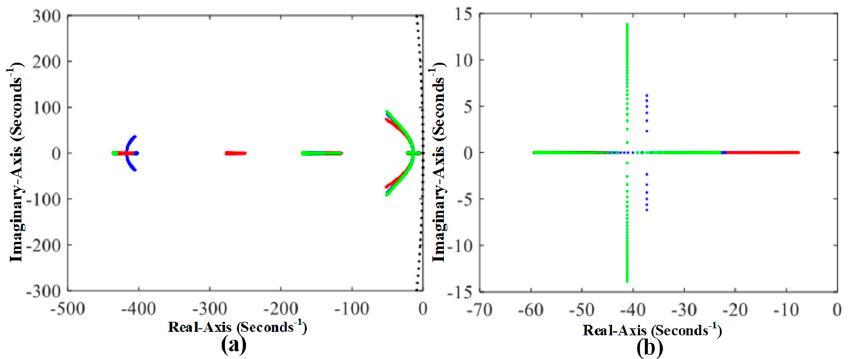
Figure 8. Pole distributions of system between different damping resistance in d -axis: ( a ) pole distribution diagram of motor before design; ( b ) pole distribution diagram of motor after design.